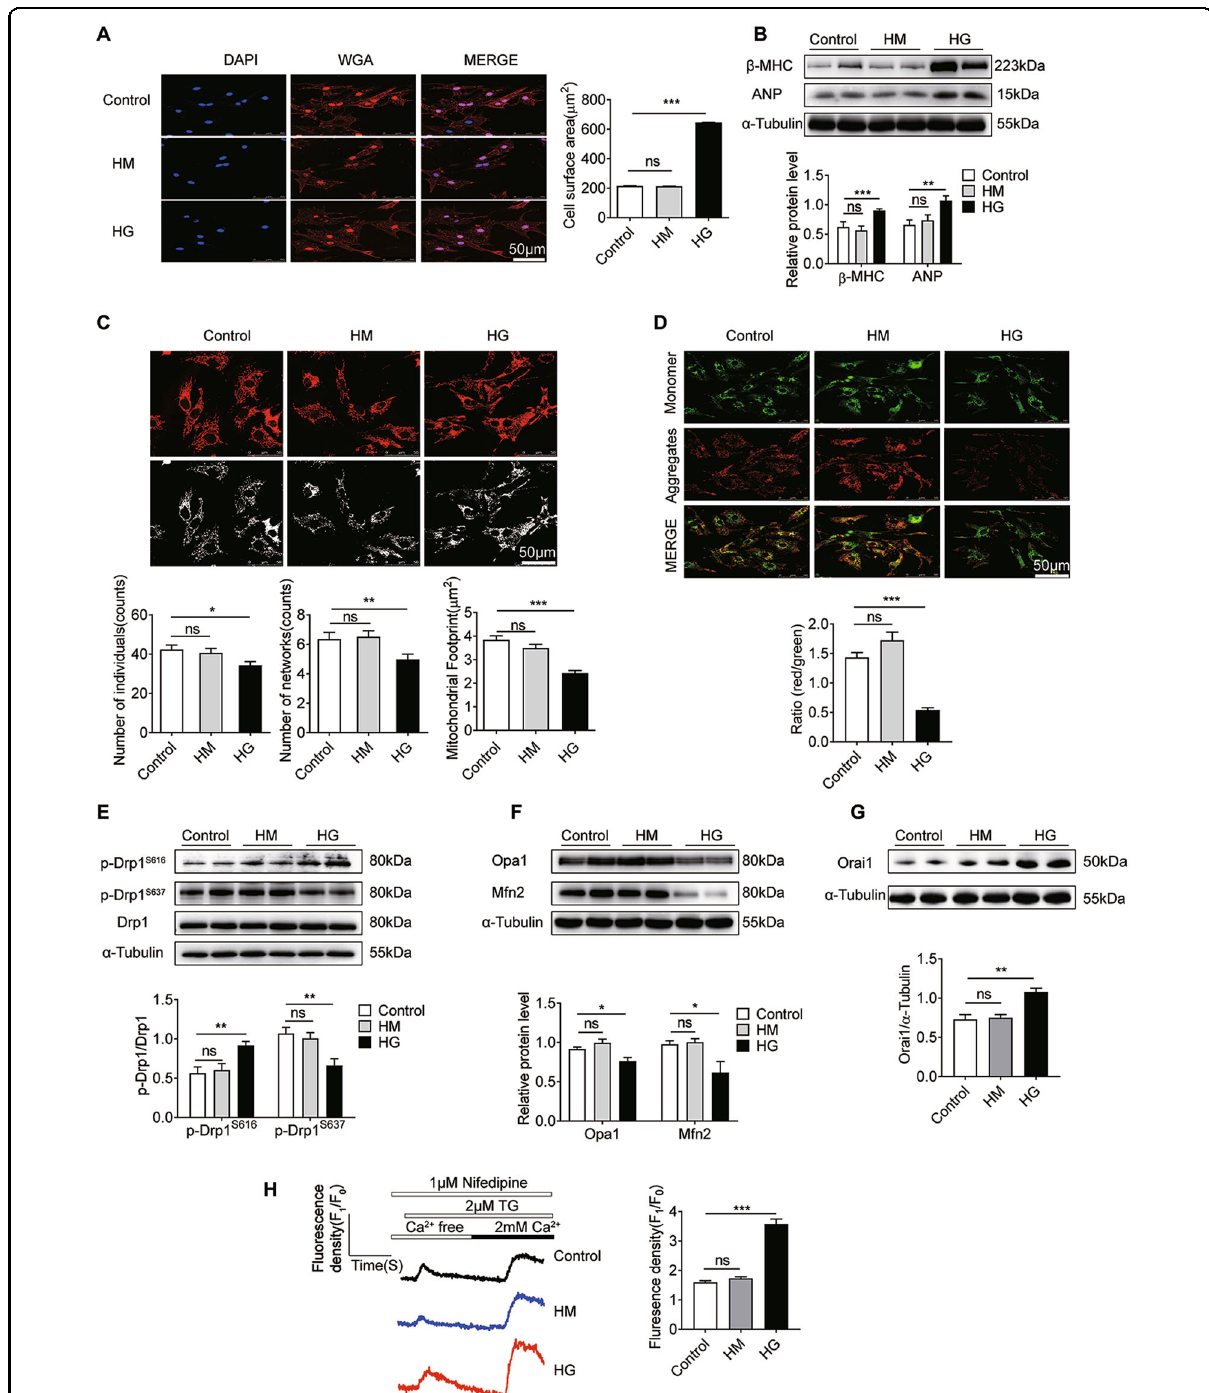
Fig. 3 (See legend on next